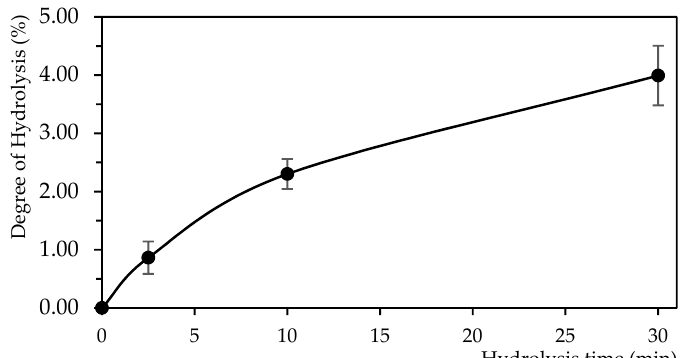
Figure 1. Evolution of the degree of hydrolysis during the 30 min peptic hydrolysis of porcine cruor.